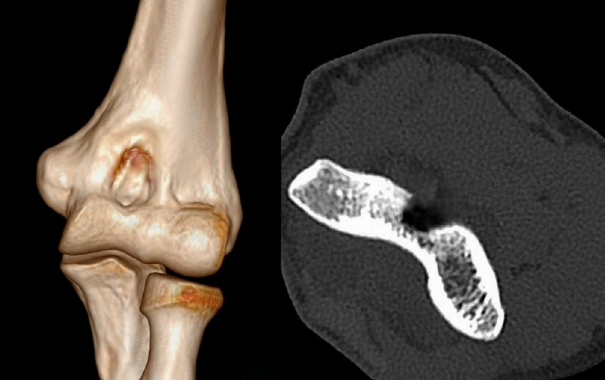
Figure 3. Post-operative computed tomography images show- ing base after removal of the osteoid-osteomas because of lack of osteo-sclerosis, pecu- liar anatomy and overlap of bones. CT scan with fi ne cuts